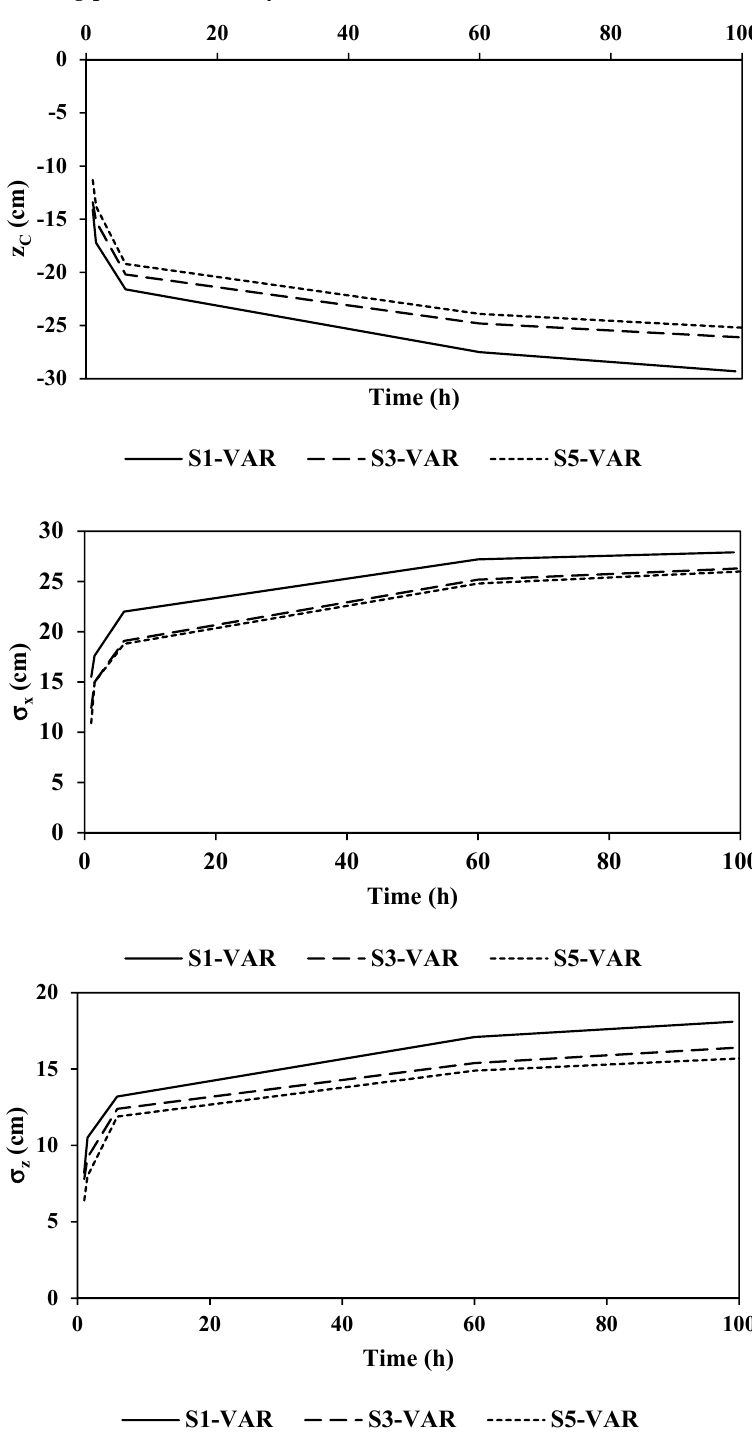
Figure 4. The location of the center of mass, z C , and the semi axes of the ellipses, σ x and σ z , with variable (VAR) ponding depth at stations 1 (S1), 3 (S3), and 5 (S5).